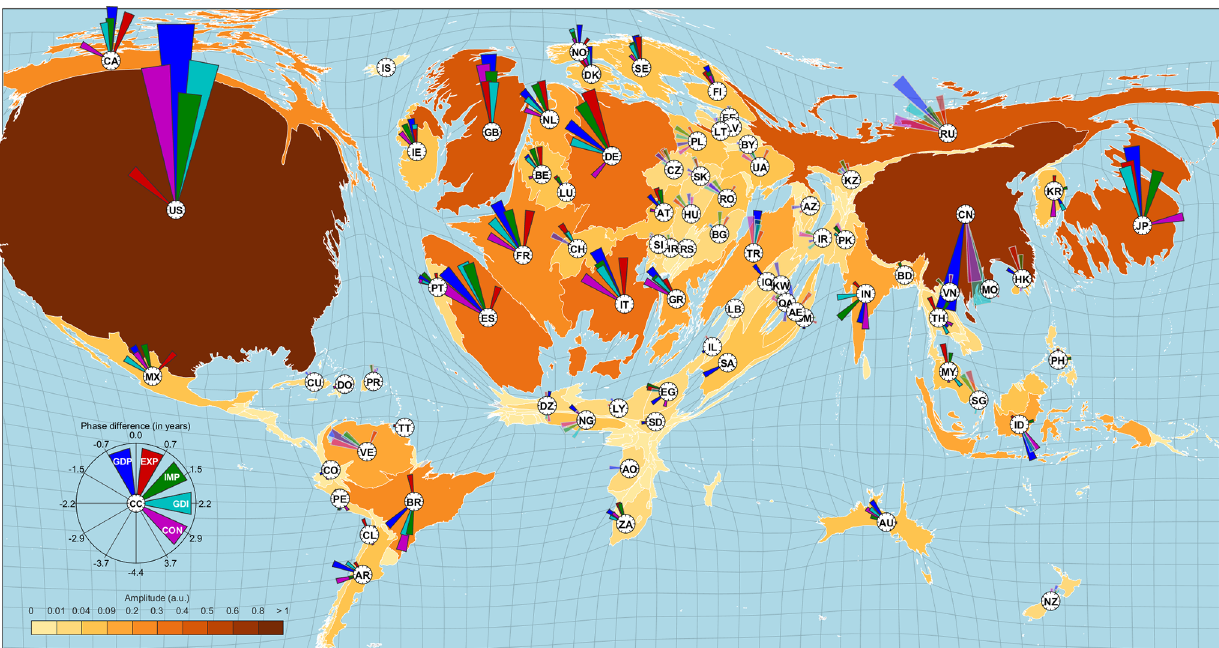
Figure 9. Leading mode of synchronized economic activity. World map of this mode’s phase and amplitude relations. For each country, the relations among the variables’ phase and amplitude are shown in a polar coordinate system, with the two-letter country code at the origin. The corresponding variable codes and colors of the pointers are given in the small compass inset at the lower left. Estimates for variables with missing values are indicated by transparent pointers. Phase differences are given with respect to USA GDP in a clockwise manner; i.e., positive and negative values indicate a phase that leads or lags the USA GDP, respectively. The land area of each country is proportional to its maximum amplitude over all of its variables. Reprinted from Groth and Ghil (2017), with the permission of AIP